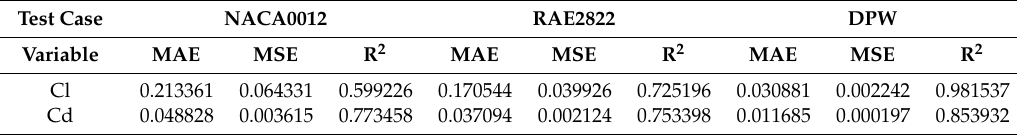
Performance metrics for the linear regression model (MAE: mean absolute error, MSE: mean squared error, R 2 : coe ffi cient of